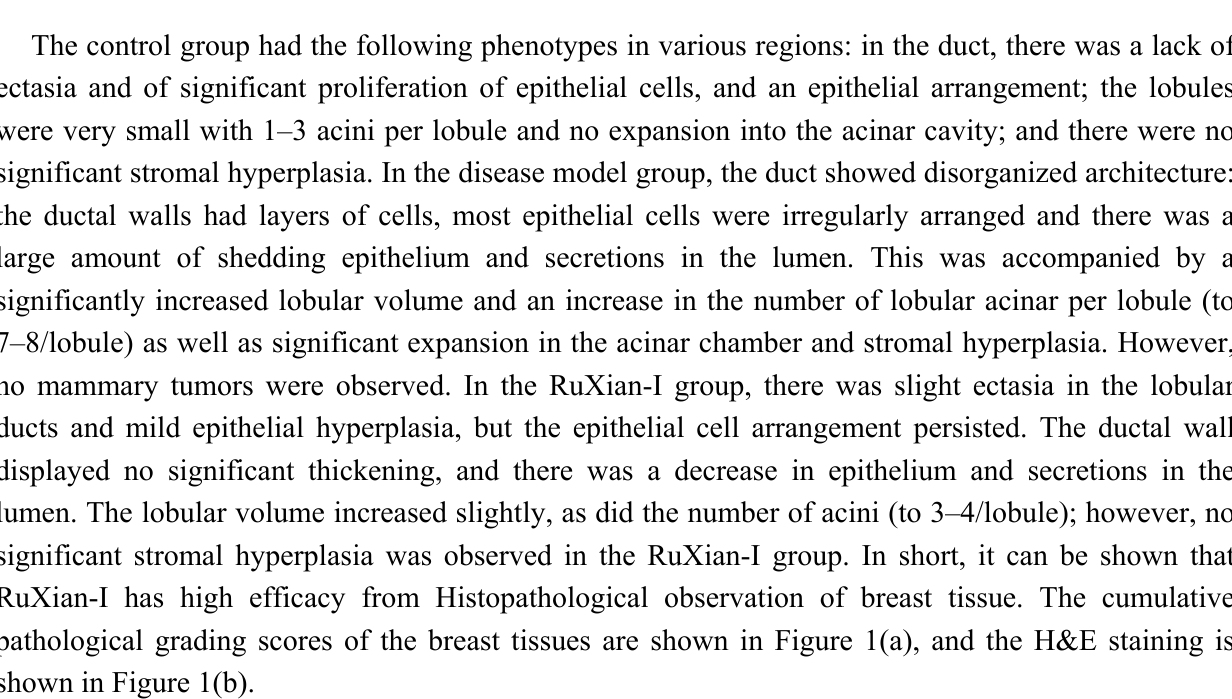
Figure 1. (a) Comparison of cumulative pathological grading scores in various groups. Score criteria, see 3.3. Values are means ± SEM. **P ≤ 0.01, compared with normal control group; ▲ P ≤ 0.05, compared with model group. (b) H&E staining of